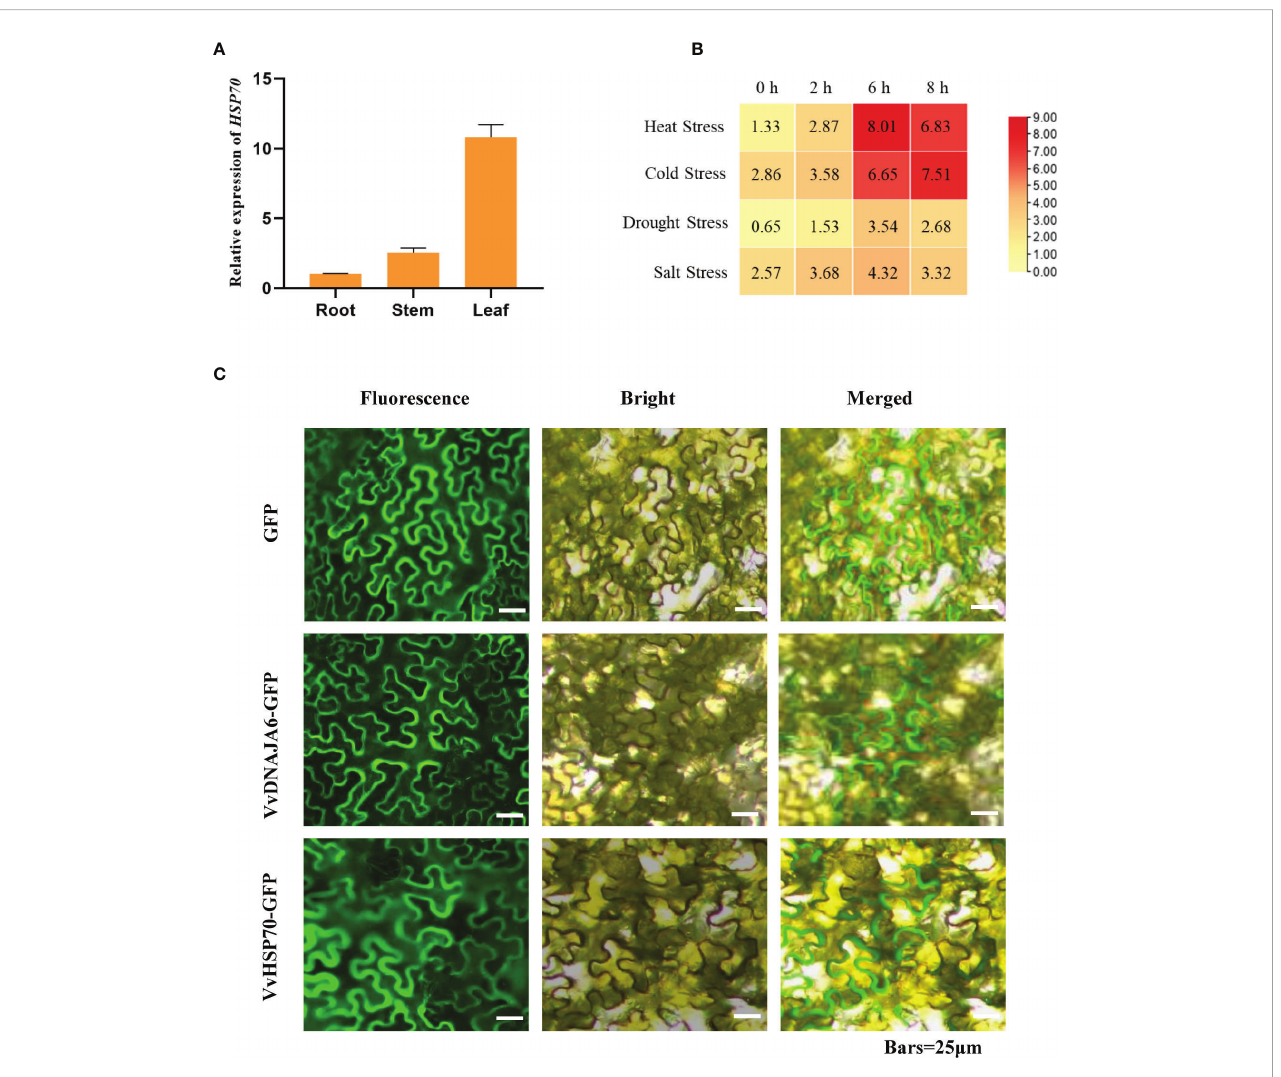
FIGURE 6 DNA JA6 may interact with HSP70 in Grapevine. (A) Relative expression of HSP70 in root, stem and leaf. (B) Different expression patterns of HSP70 in heat stress, cold stress, drought stress and salt stress. (C) Subcellular localization of DNA JA6 and HSP70. The results perform the mean ± SE of three independent replicates ( P <